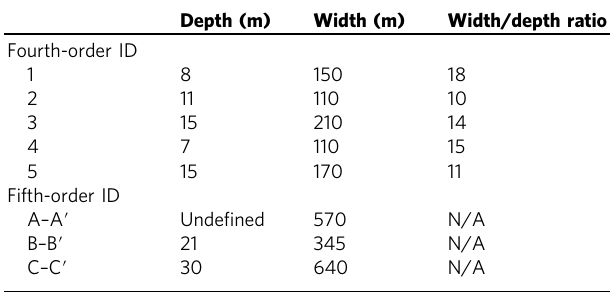
Table 2 Fourth and fi fth order observed bounding surface